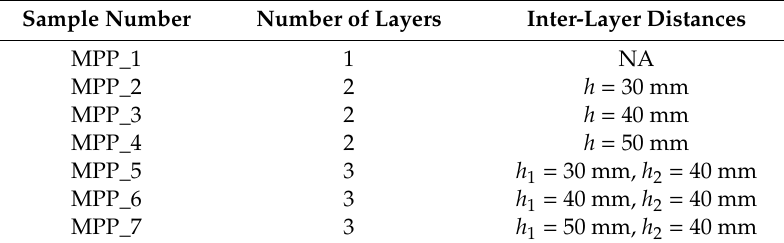
Table 1. Geometric parameters of the tested specimens.